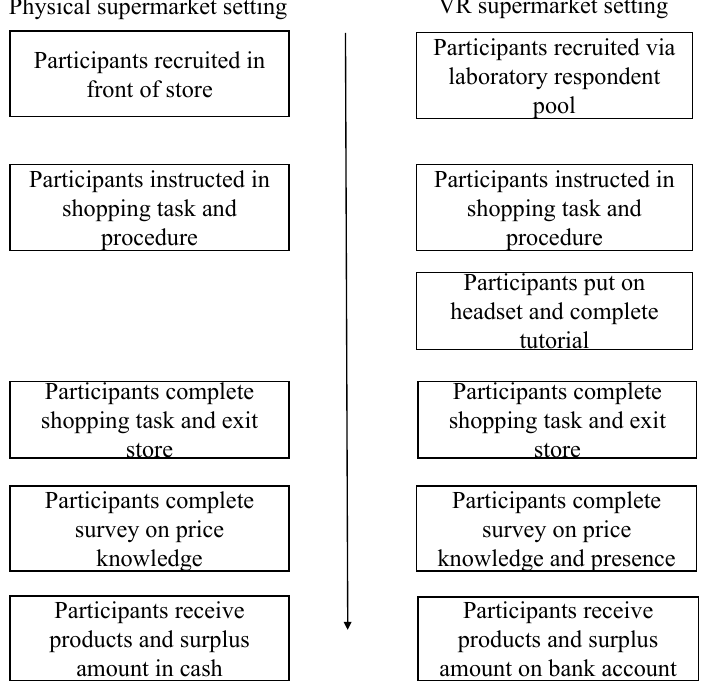
Figure 1. Overview of the data collection procedure.